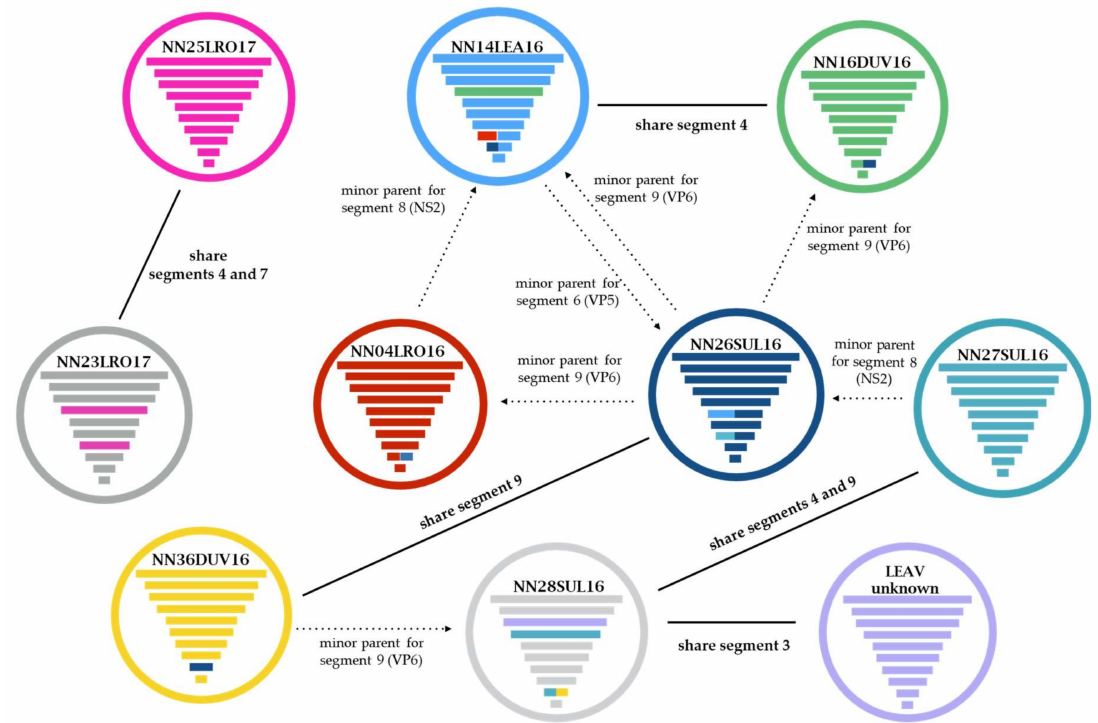
Figure 3. Graphical representation of gene reassortment and intragenic recombination between LEAV strains. Each colored circle represents a di ff erent LEAV strain. The 10 horizontal lines inside the circles represent the 10 genomic segments. Solid lines indicate reassortments of genes between di ff erent LEAV variants. Dashed arrows show the origins of gene fragments that have potentially been derived through